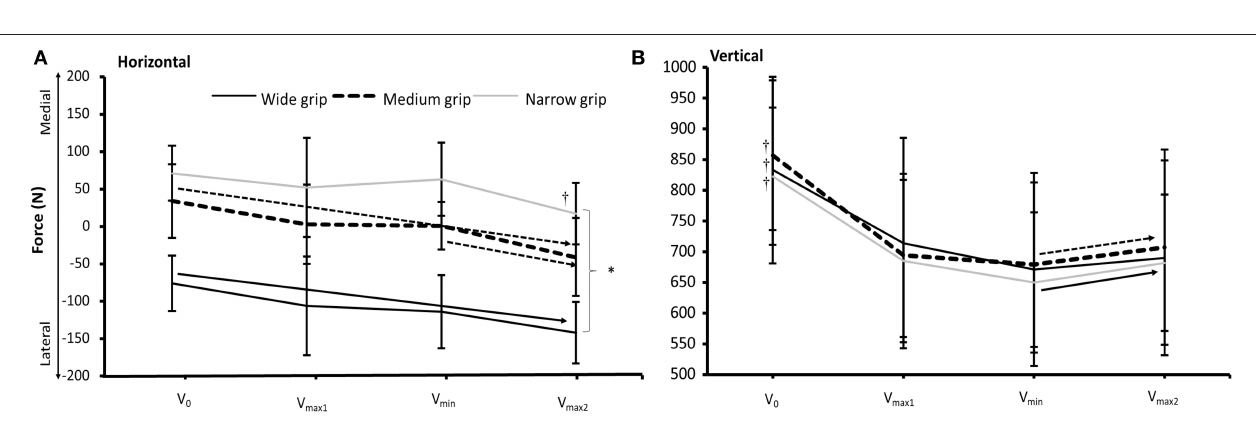
FIGURE 3 | (A) Shoulder abduction, (B) shoulder flexion, and (C) elbow extension expressed as mean (SD) in v 0 , v min , v max2 , v 0, and v max1 for the wide, medium, and narrow grip bench press conditions. *Indicates a significant difference when compared with the other two grip widths. † Indicates a significant difference between the two specified grip widths.